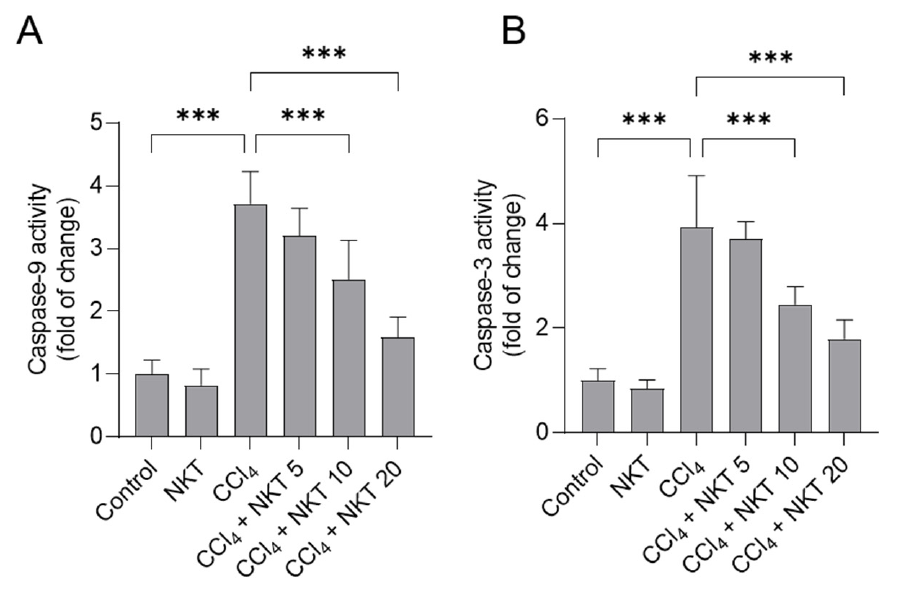
Figure 7. NKT pretreatment decreases the levels of caspases-9 and -3 in the kidneys of CCl 4 -treated mice. Mice were treated as described in the previous figures. After 24 h, the levels of caspases-9 ( A ), and caspase-3 ( B ) in the kidney tissues of mice were determined, respectively. Data are shown as mean ± S.D. ( n = 8 in each group). *** p < 0.001.